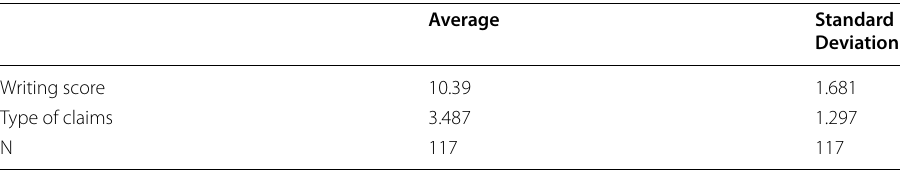
Table 7 Descriptive analysis of writing scores and claim types